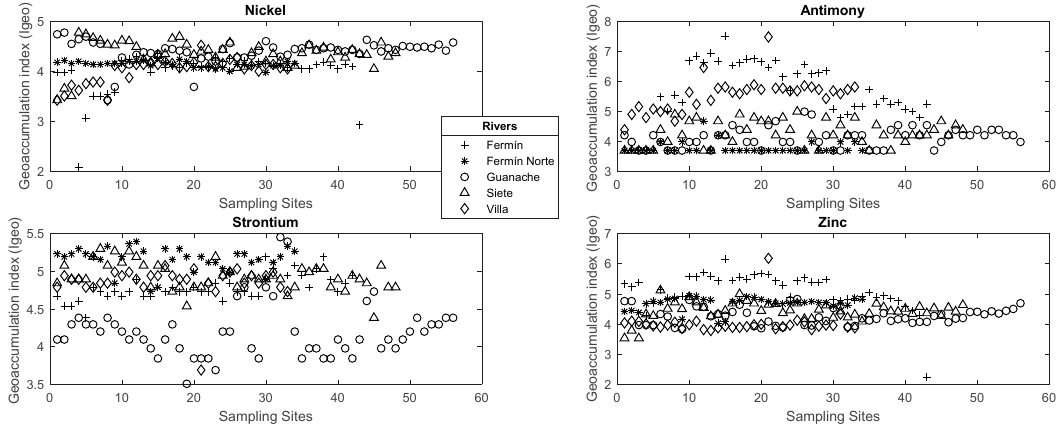
Figure 6. Downstream longitudinal sequence plots of Igeo for Ni, Sb, Sr, Zn.